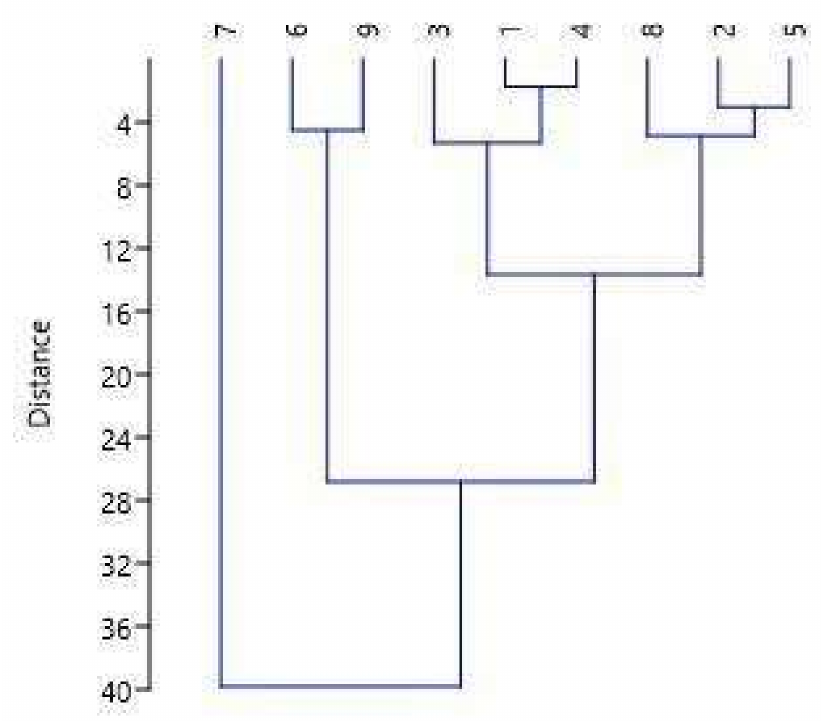
Figure 3. Hierarchical clustering based on elemental composition of HAs. Ward’s